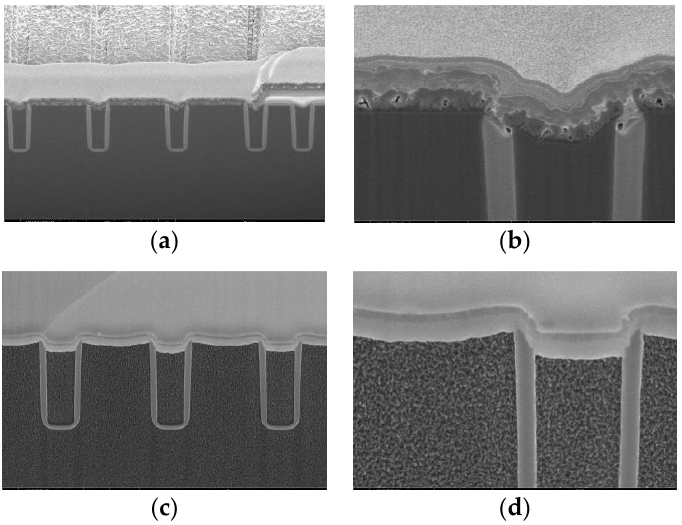
Figure 8. Cross-sectional view of TMBS diode at low and high magnification for ( a , b ) GNW-TMBS diode ( c , d ) TiSi 2 -TMBS diode.